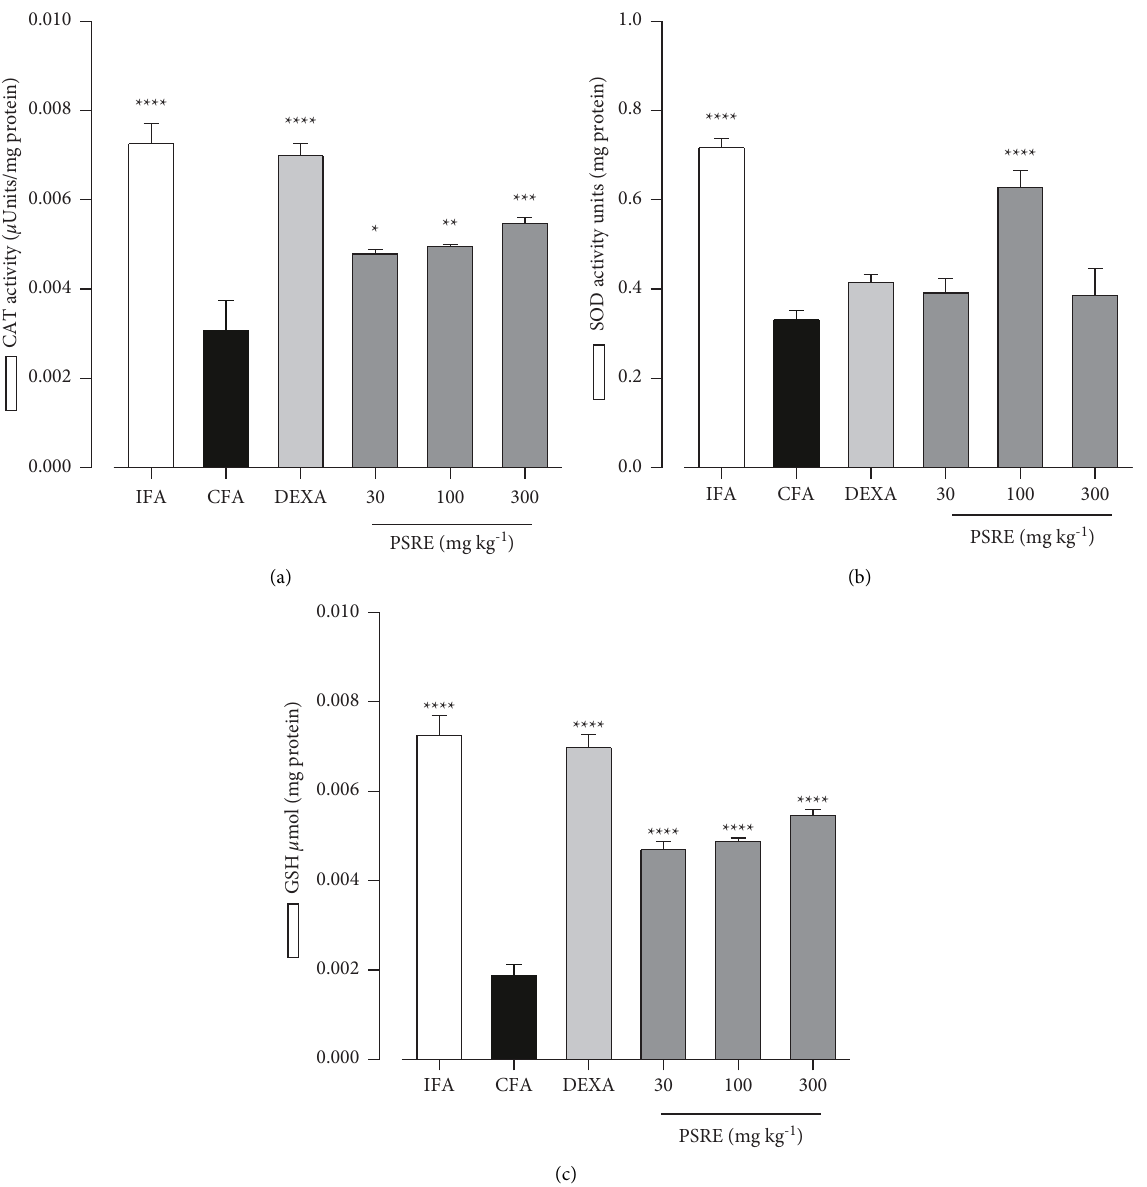
Figure 7: The effect of PSRE and dexamethasone on serum CAT (a), SOD (b) and GSH (c) activities of rats in the therapeutic adjuvant arthritis study. Values are the mean SEM ( n 5–6). Significantly different values: (cid:31) compared to CFA group (One-way ANOVA analysis followed by Tukey’s multiple comparison ±